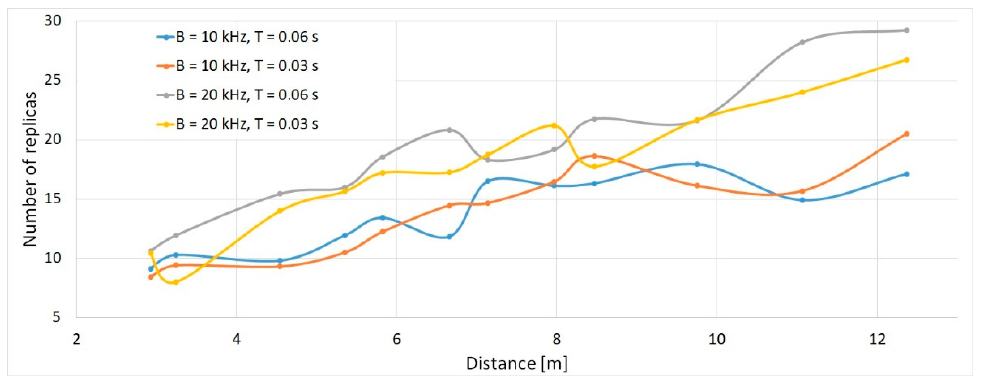
Figure 10. Comparison of the number of replicas as a function of the transmitter–receiver distance for different chirp bandwidths, B , and the duration, T .